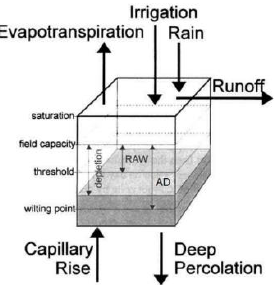
Figure 1. Water balance [29].